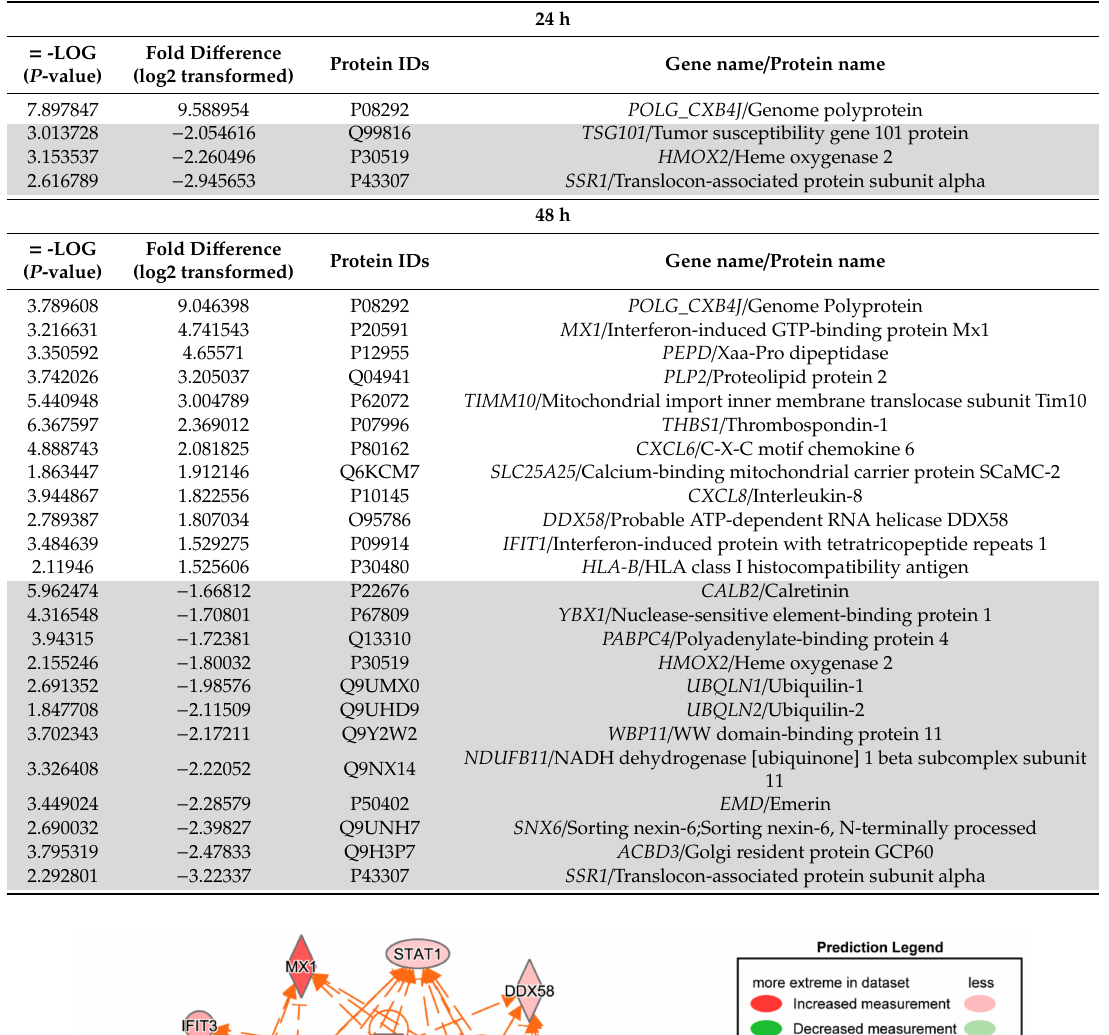
Table 1. Proteins with > 1.5-fold (log 2 ) di ff erence in CVB4-infected compared to uninfected SC- β cells at 24 and 48 h.